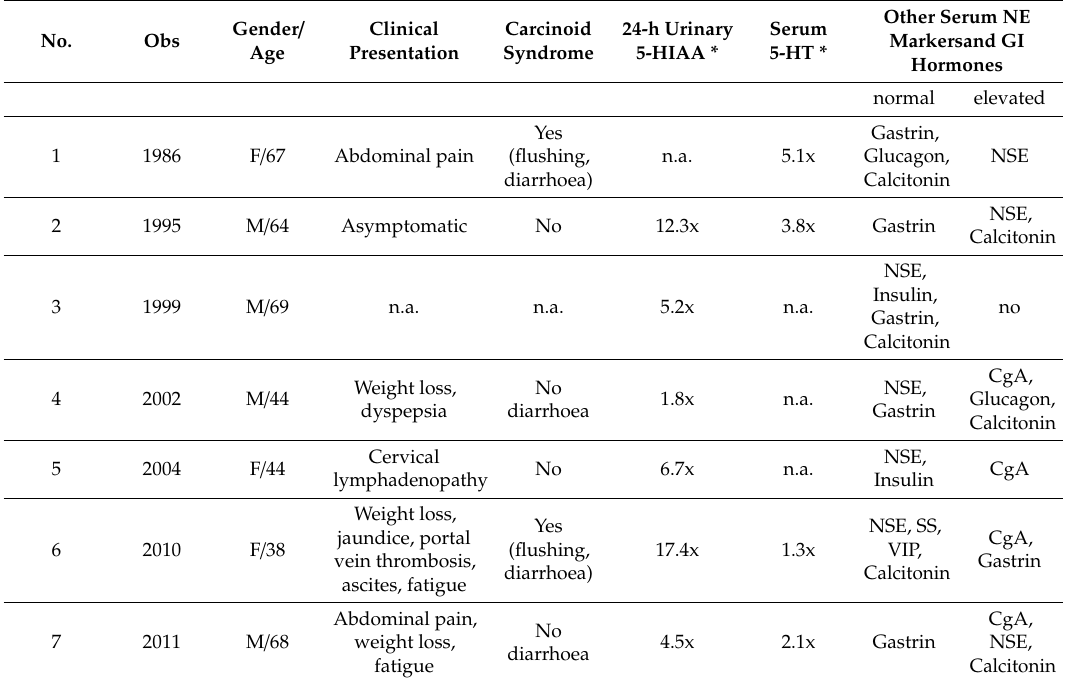
Table 1. Clinical presentation and laboratory tests at diagnosis in patients with serotonin-secreting pancreatic NETs.